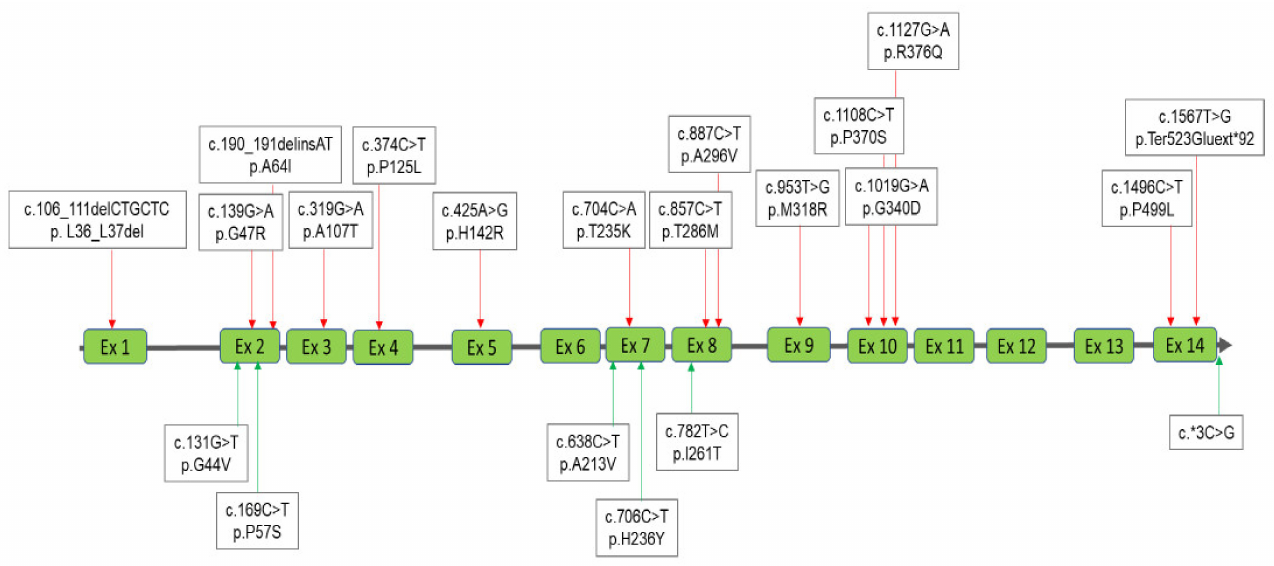
Figure 4. A total of 21 mutations of the GALNS gene underlying Taiwanese Morquio A syndrome were found; of those 15 had been reported previously (red lines with arrows) and the other six were novel mutations (green lines with